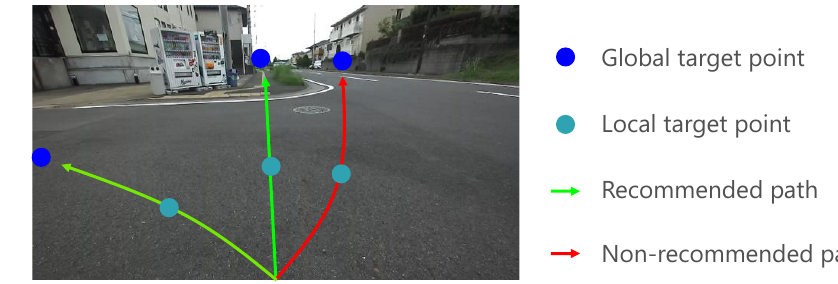
Figure 1. Potential path